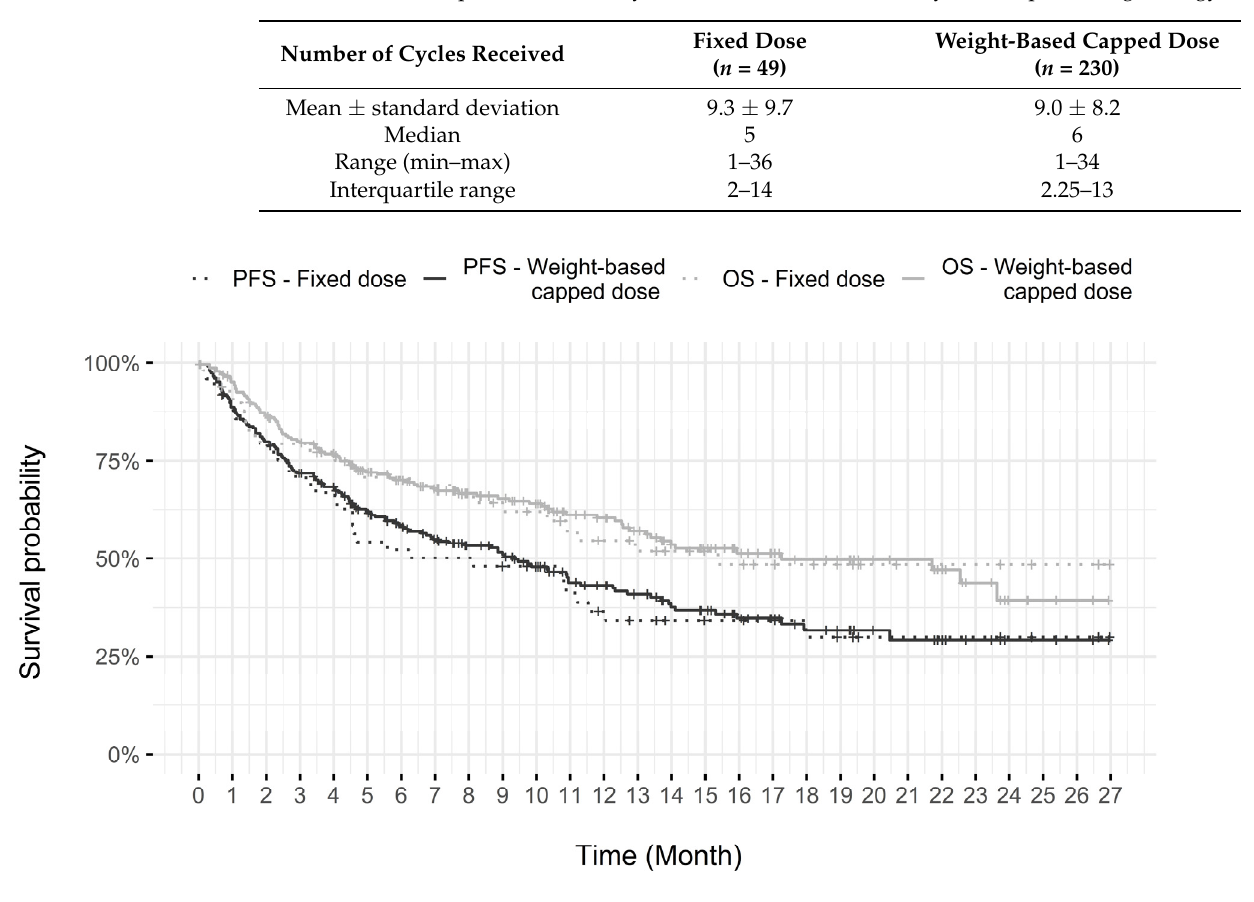
Figure 2. Progression-free survival and overall survival of the study population with regards to pembrolizumab dose used ( n =